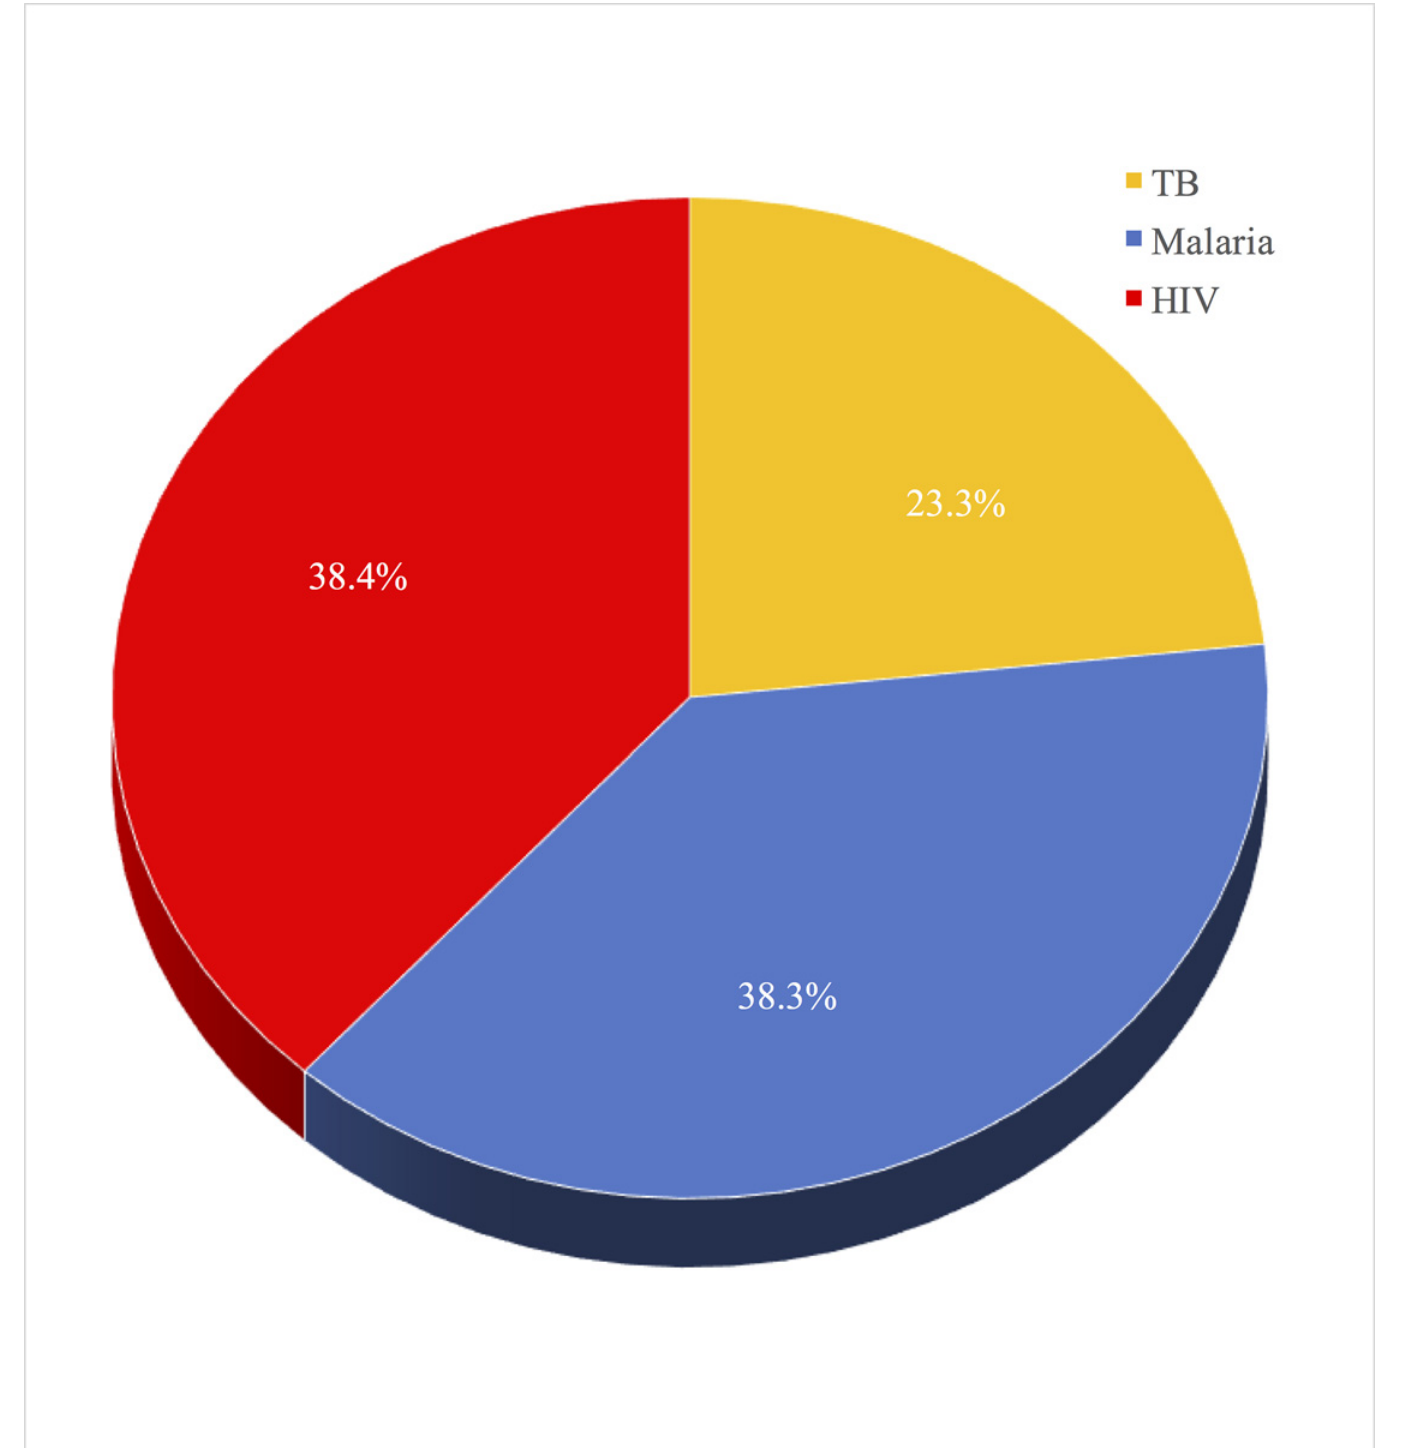
Fig 2. Total impact scores for drugs aggregated by disease. What proportion of aggregate drug impacts is attributable to Malaria, TB, and HIV.